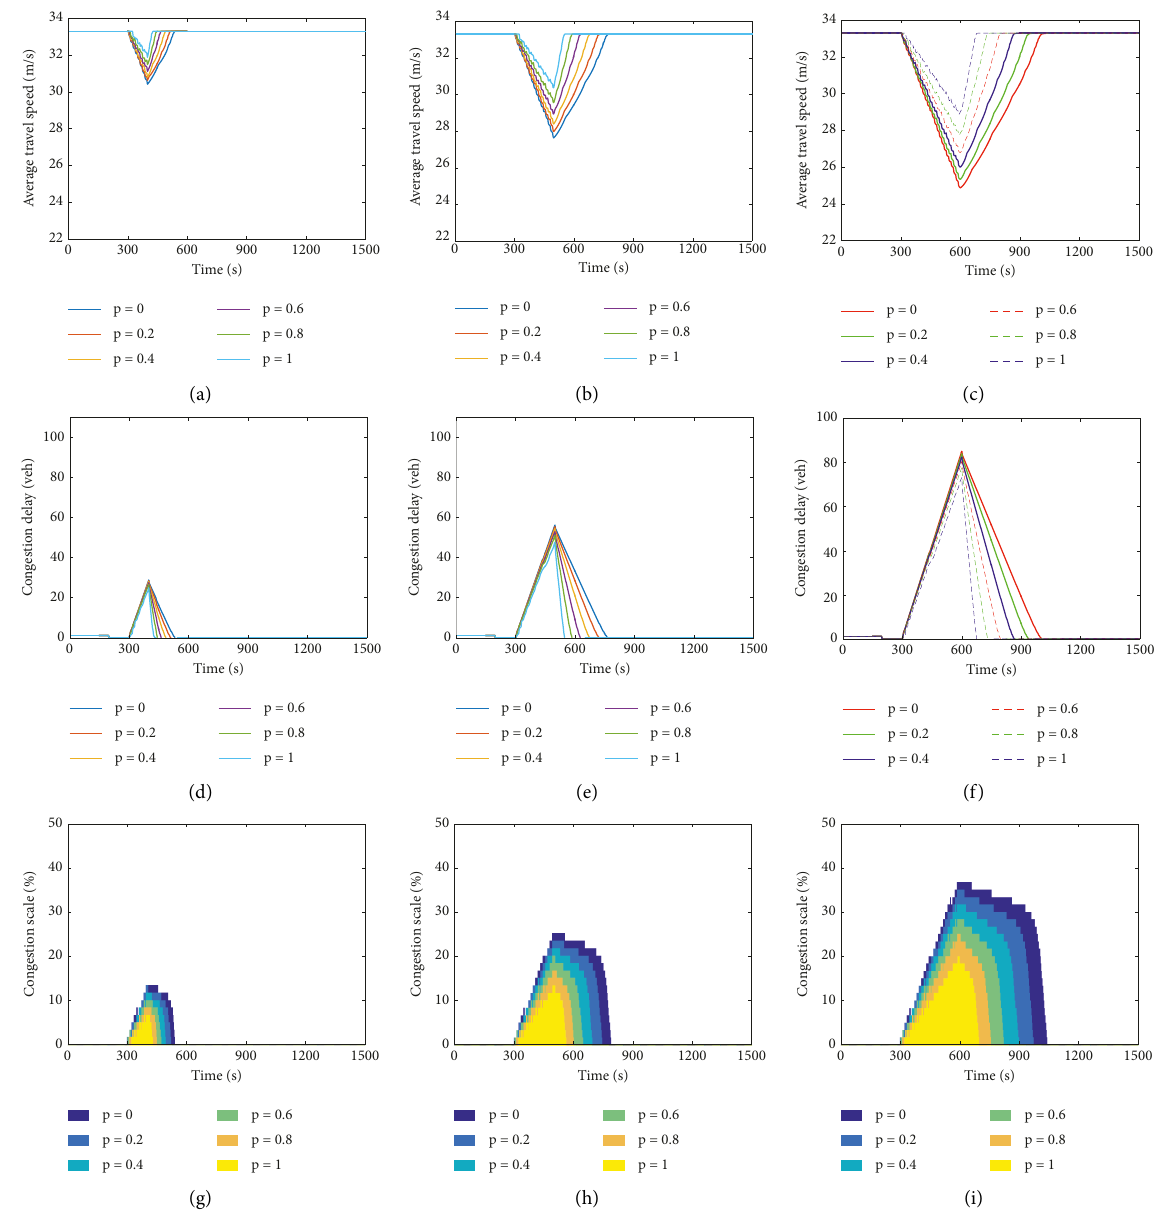
Figure 14: Traffic congestion indexes under different bottleneck duration: (a) average travel speed (100 s), (b) average travel speed (200 s), (c) average travel speed (300 s), (d) congestion delay (100s), (e) congestion delay (200 s), (f) congestion delay (300 s), (g) congestion scale (100s), (h) congestion scale (200 s), and (i) congestion scale